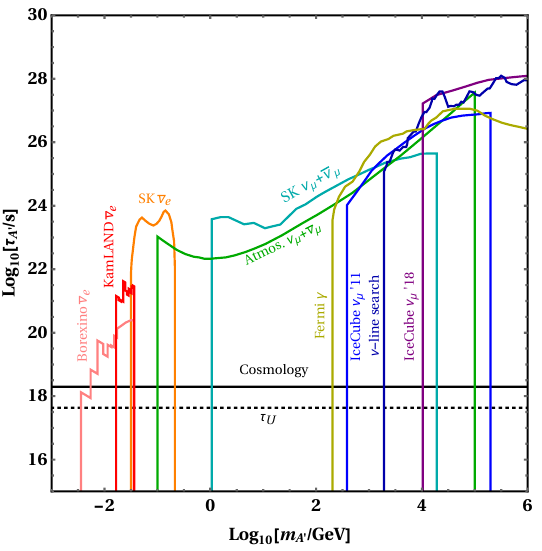
Figure 4 . Bounds on the lifetime of dark matter assuming it decays only into ν ¯ ν . Here we assume that the DM couples universally to the three neutrinos